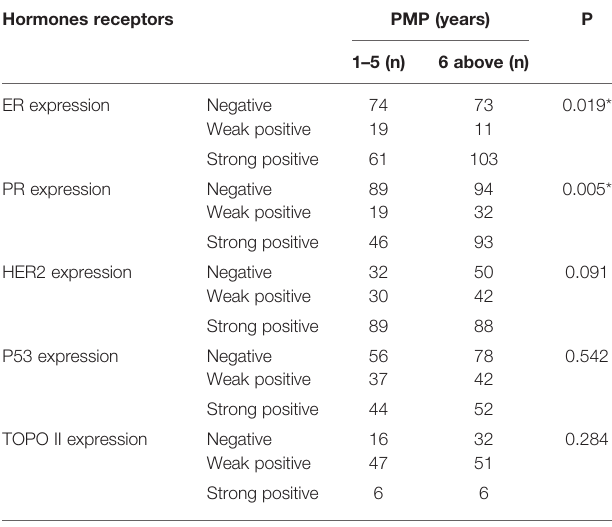
TABLE 3 | Association between PMP and hormone receptors in breast cancer patients. Hormones receptors